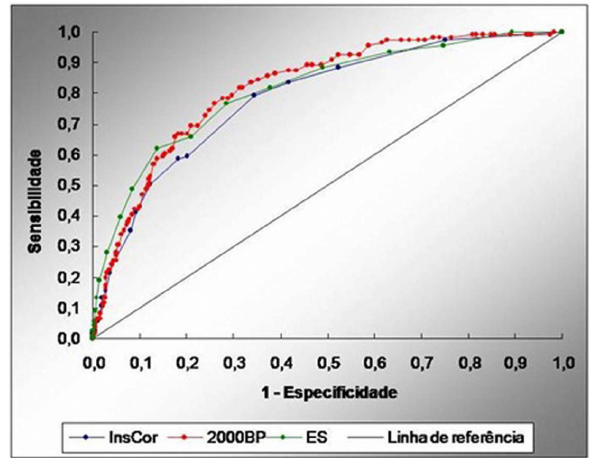
Fig. 1 - Curva ROC para o InsCor (10 variáveis), o 2000Bernstein- Parsonnet (44 variáveis) e o EuroSCORE (17 variáveis) no InCor-